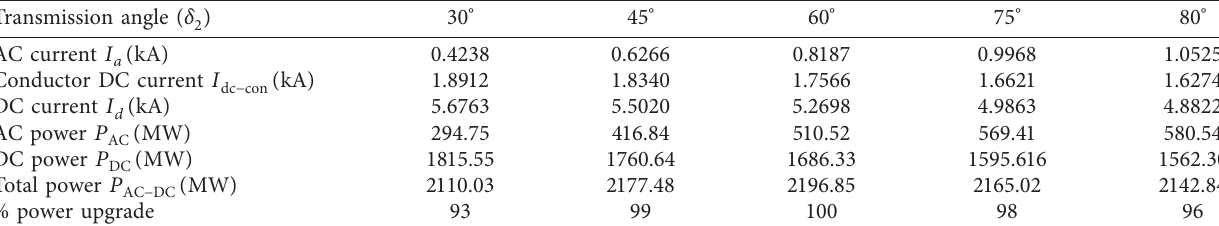
Table 1: Computed results at various transmission angles.